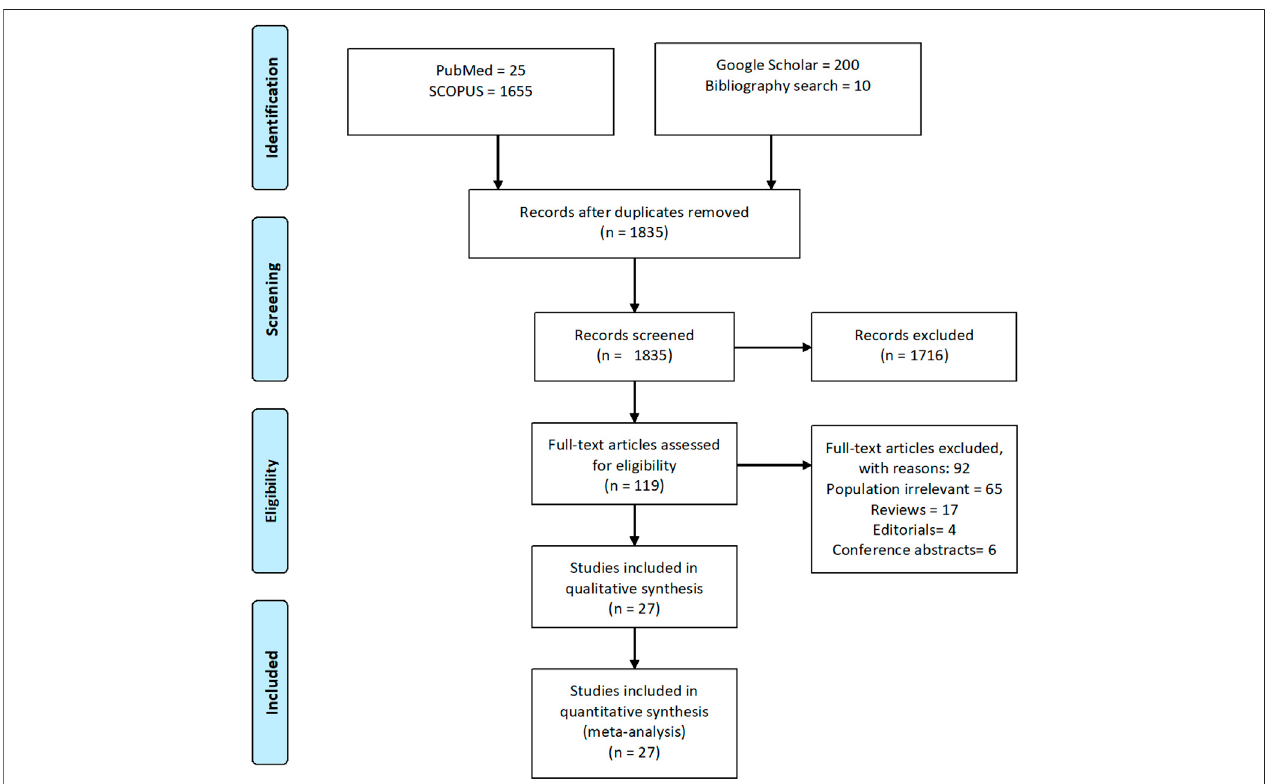
FIGURE 1 | PRISMA diagram of the literature selection in this systematic literature review and